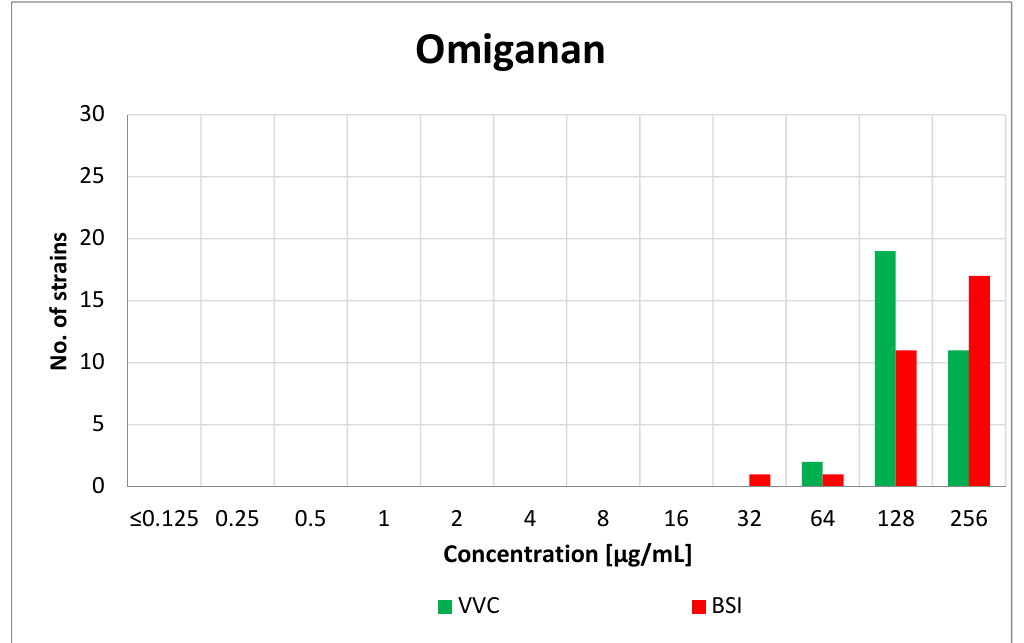
Figure 2. Distribution of the MICs of Omiganan among the vaginal (VVC) and blood-derived (BSI) Candida strains.